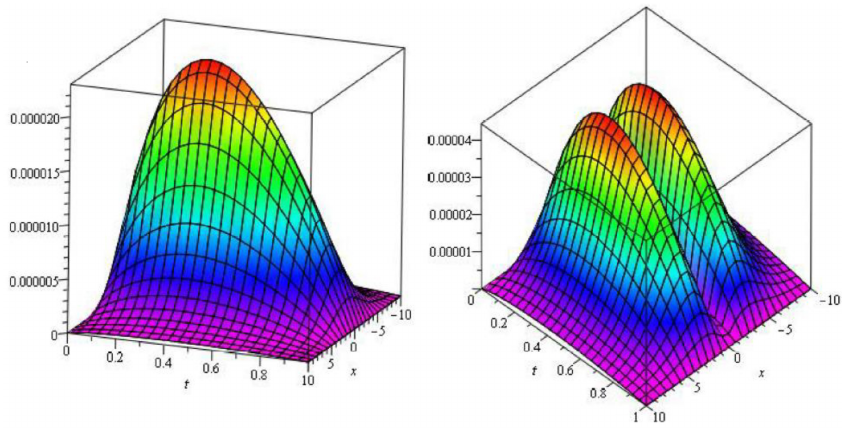
Figure 4. Error graphs of µ ( ζ , τ ) and ν ( ζ , τ ) at ρ = 1 of example